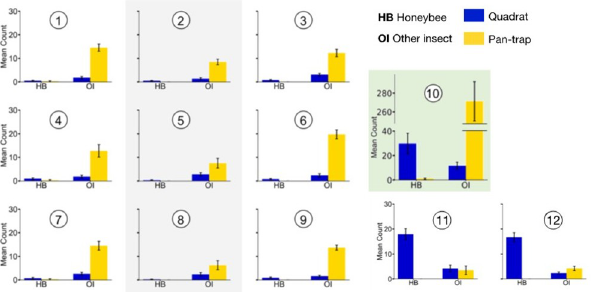
Fig 6. Quadrat observations (blue) and pan-trap counts (yellow) of honeybees (HB) and other insects (OI). Strawberry polytunnels (1–9), weeds (10–note axis scale), raspberry polytunnels (11–12)–see Fig 5 for polytunnel layout. Grey shading indicates the middle of the strawberry polytunnels, green shading indicates the weed area. Error bars represent the standard error of the mean. https://doi.org/10.1371/journal.pone.0251572.g006 Pan-traps. Flower type had a significant effect on non-honeybee insect counts ( z = -4.659;